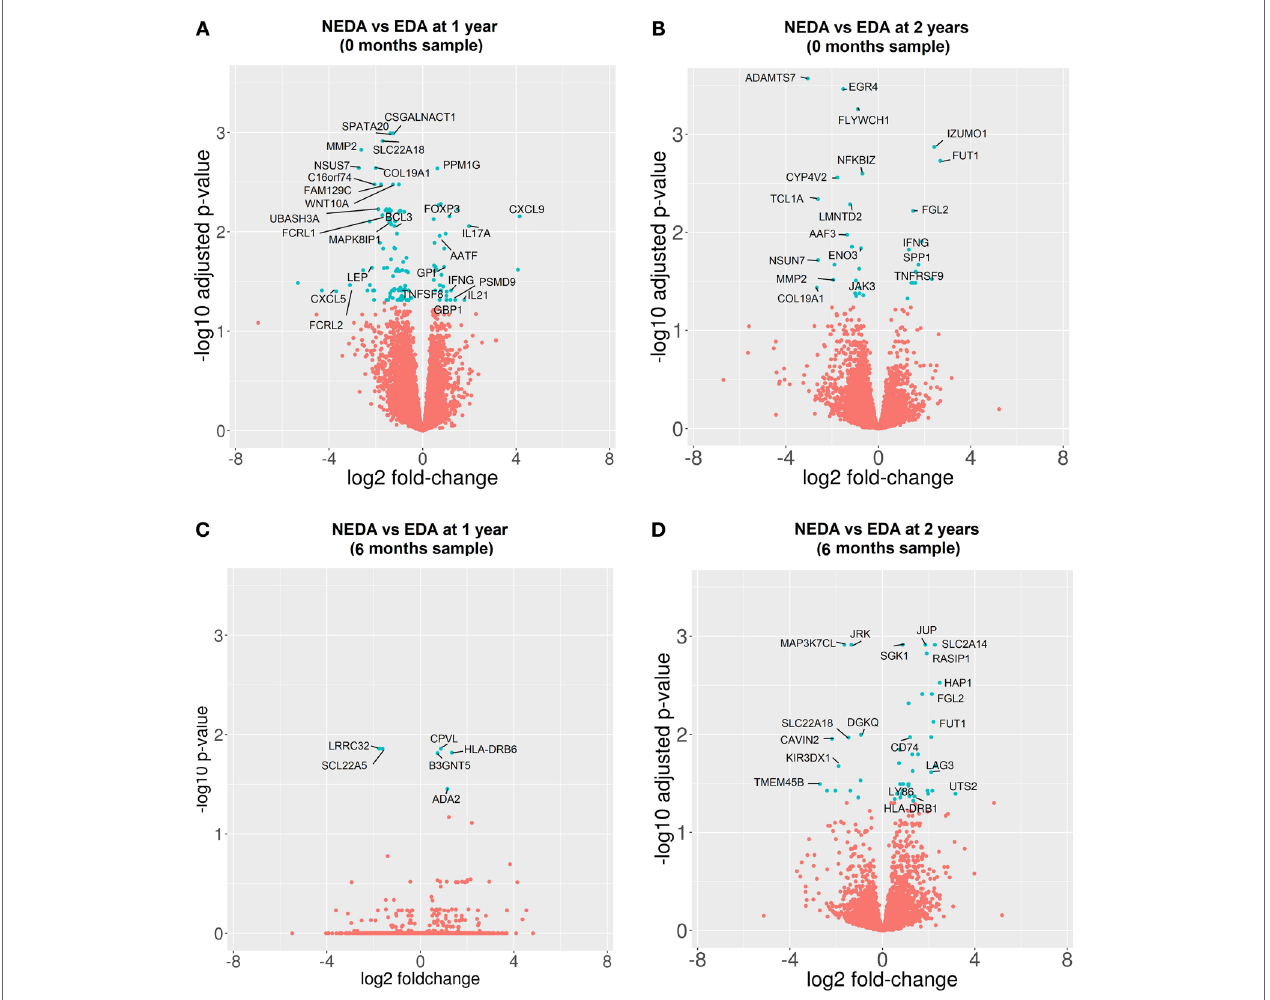
FigUre 5 | Differentially expressed genes (DEGs) between responder (R) and non-responder (NR) patients before and after 6 months of treatment. Volcano plots of DEGs between R and NR patients. (a,B) Samples obtained before treatment. Clinical response measured at 1 year (a) and 2 years (B) . (c,D) Samples obtained after 6 months of treatment. Clinical response at 1 year (c) and 2 years (D)